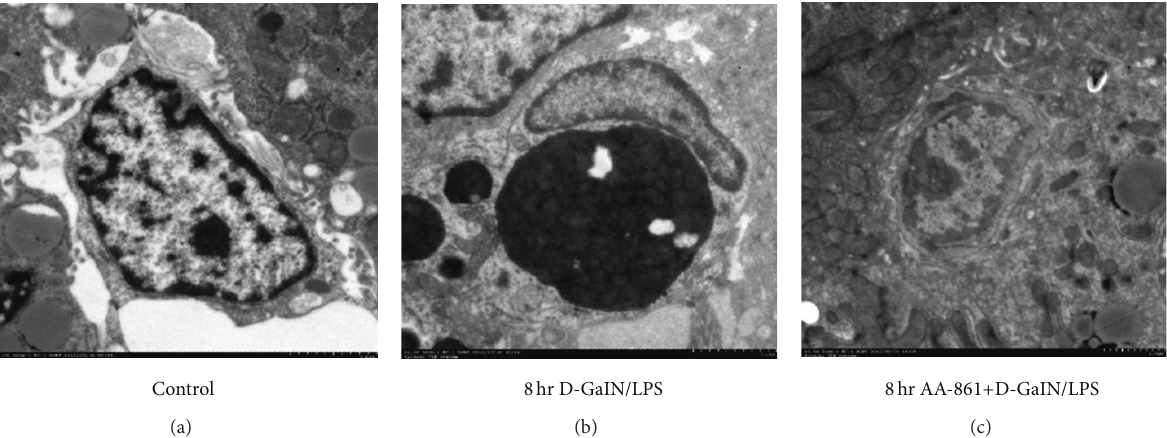
Figure 6: AA-861 markedly inhibited the morphological changes in macrophages. Representative electron micrographs (the scale for the picture is 2 𝜇 m) of liver sections from control (a) and 8 hr D-GalN/LPS-treated rats receiving placebo (b) or AA-861